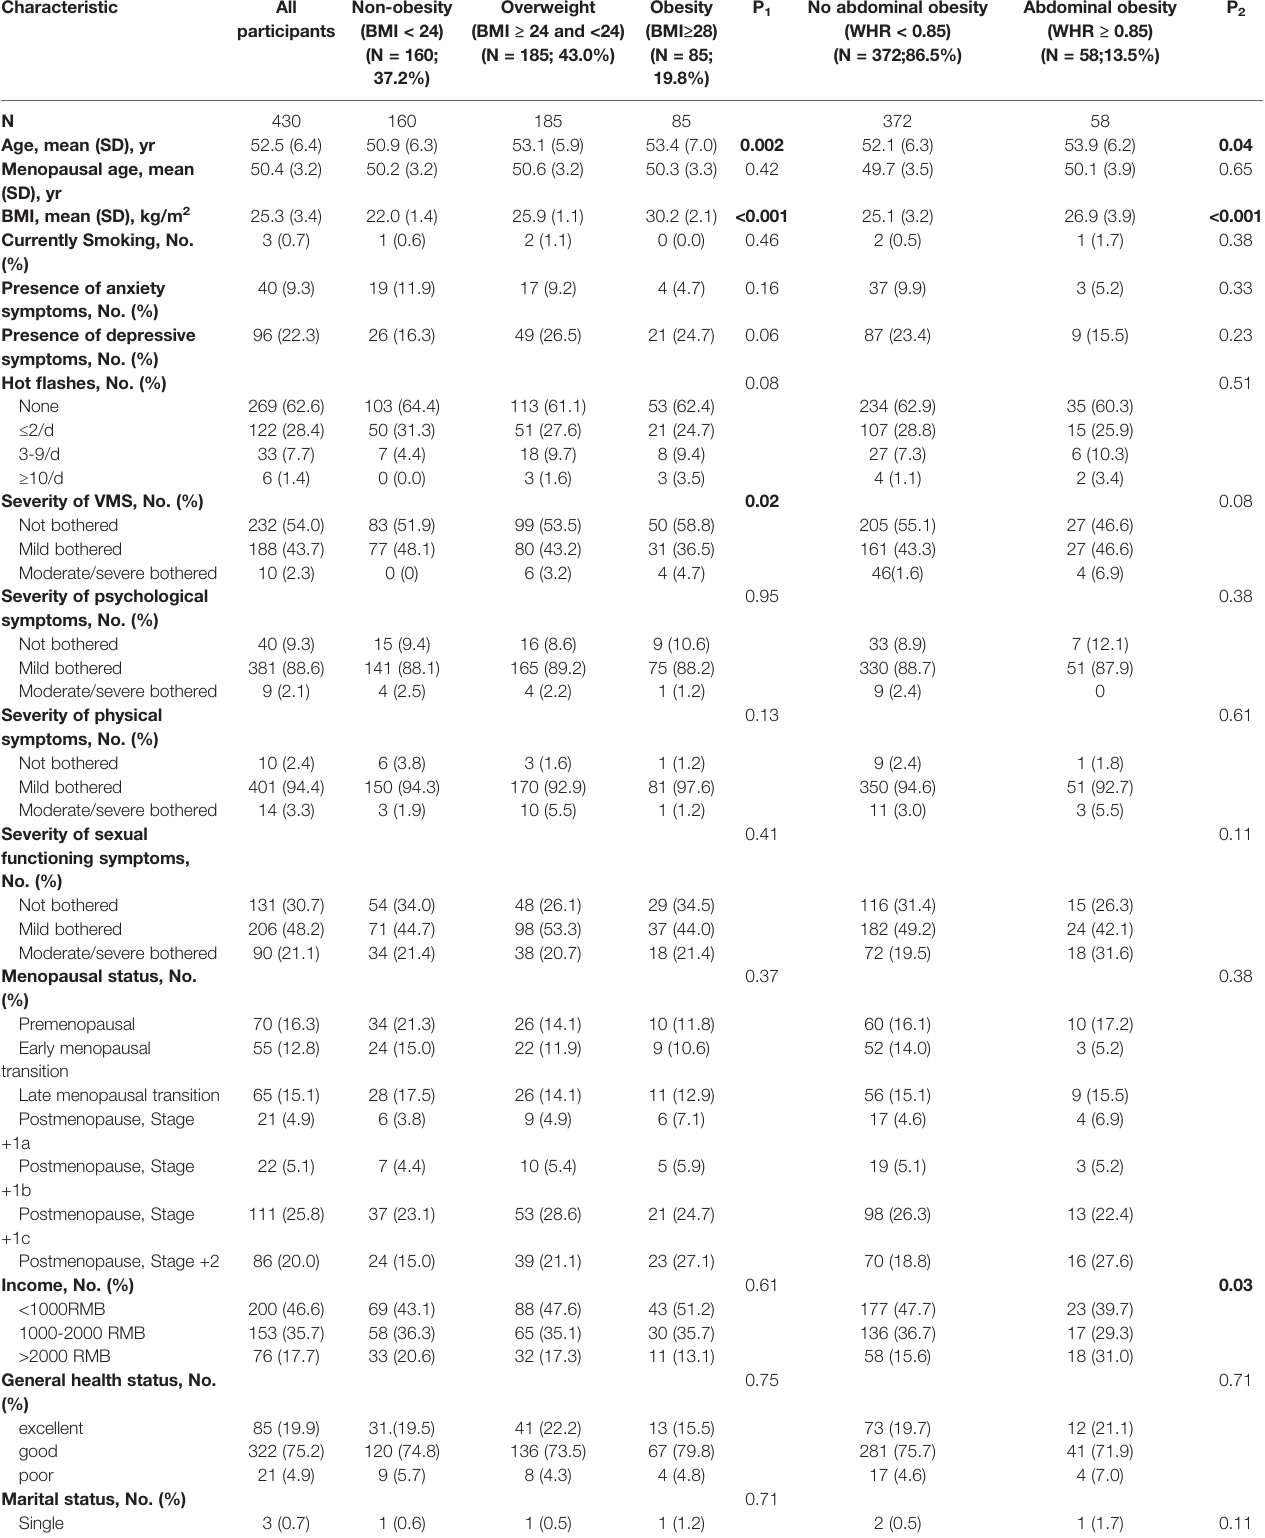
TABLE 1 | Baseline sample description of all participants according to the presence of obesity and abdominal obesity.